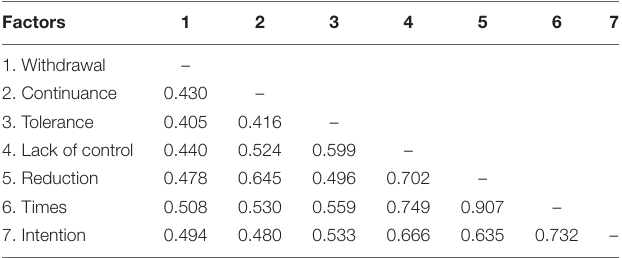
TABLE 3 | Inter-correlations between the seven latent